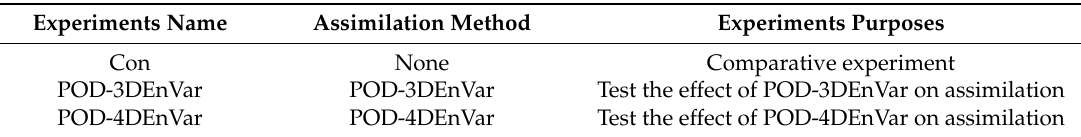
Figure 5. Simulated brightness temperature of FY-3A MWHS channel 4 in the assimilation window. The background is the model domain. Table 4. Design of observation system simulation experiments (OSSEs).